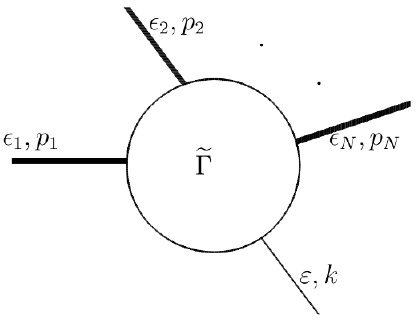
Figure 2 . The subleading